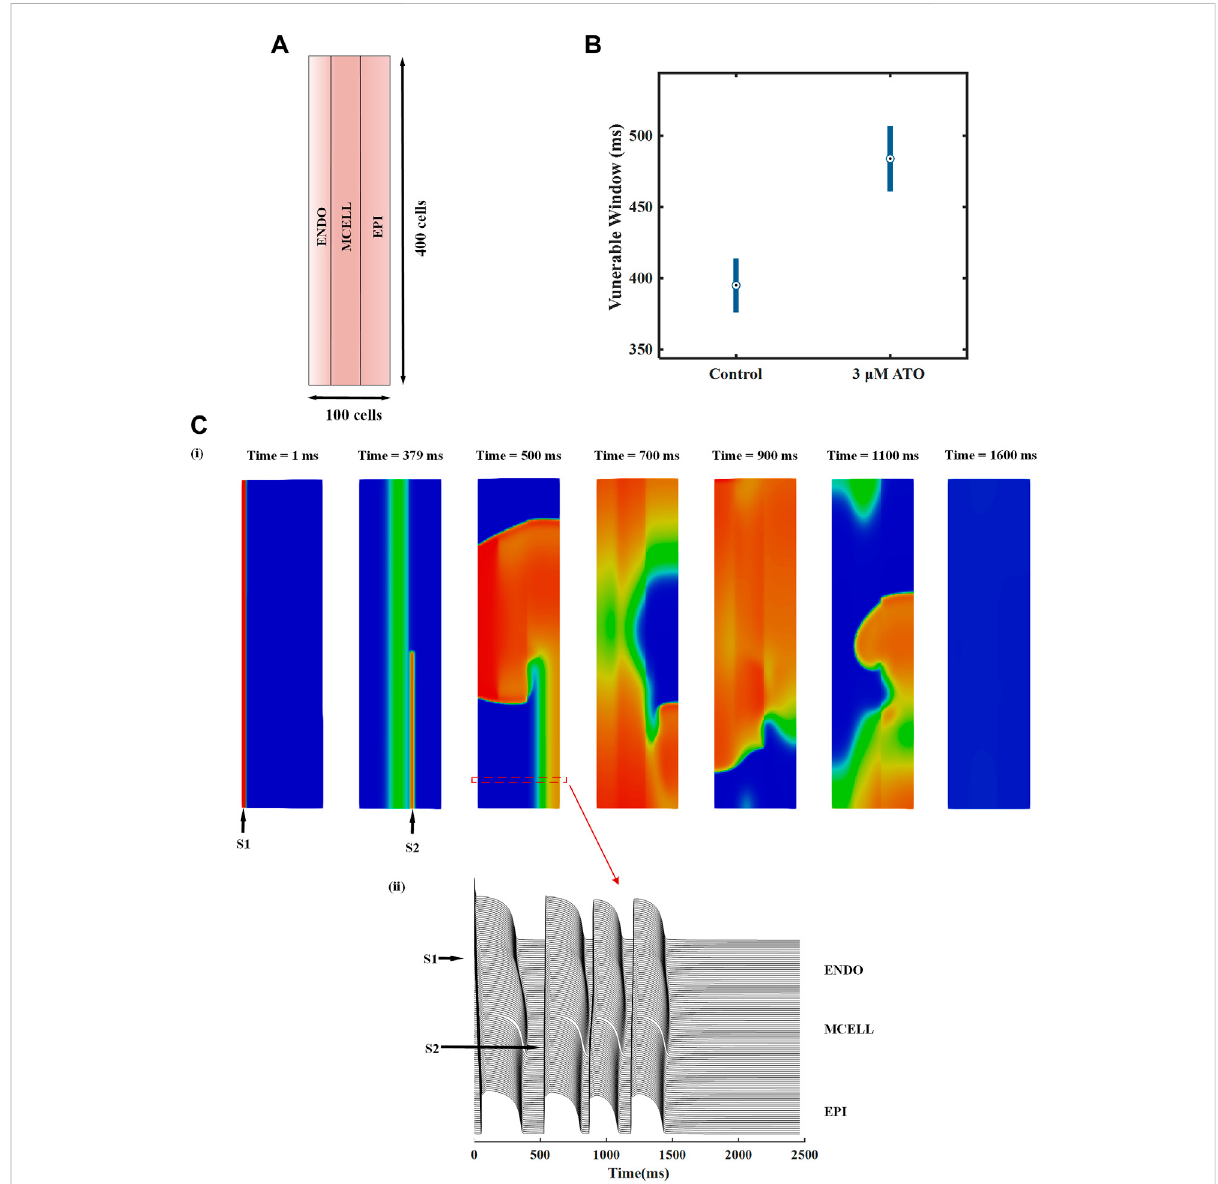
FIGURE 6 The effect of ATO on heterogeneous ventricular tissue. (A) The structure of heterogeneous ventricular tissue. (B) The vulnerable window of ventricular tissue in control and 3 μ M ATO conditions. (C) Snapshots of reentrant excitation waves in the control condition with S1-S2 intervals at 378 m and sequence diagram of the membrane potential of horizontal continuous ventricular myocytes.